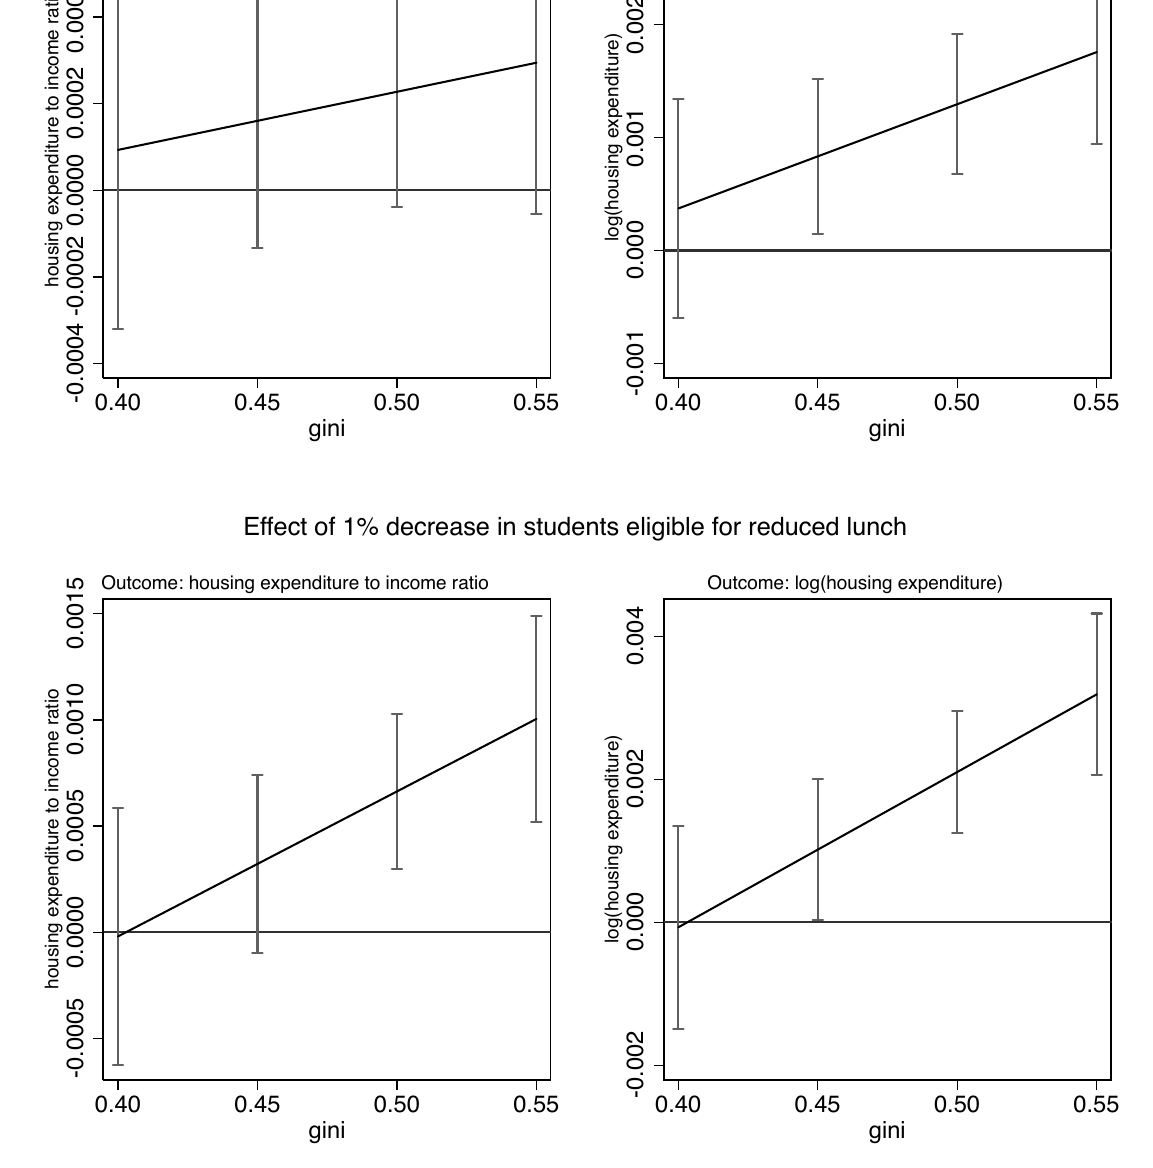
Figure 4: Predicted housing expenditures by income inequality